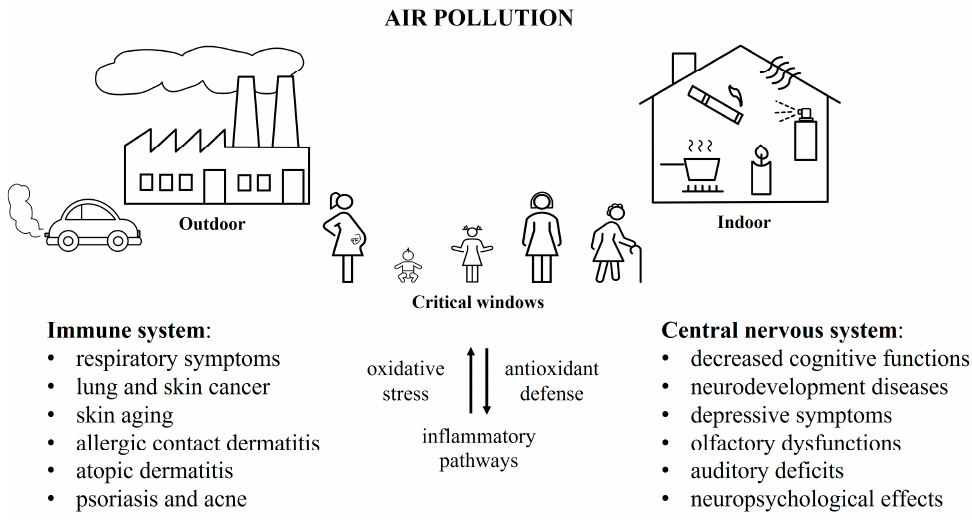
Figure 1. Effects of indoor and outdoor air pollutants on immune and nervous system. Susceptibility during critical windows and involvement of oxidative stress and inflammatory pathways are re- ported.